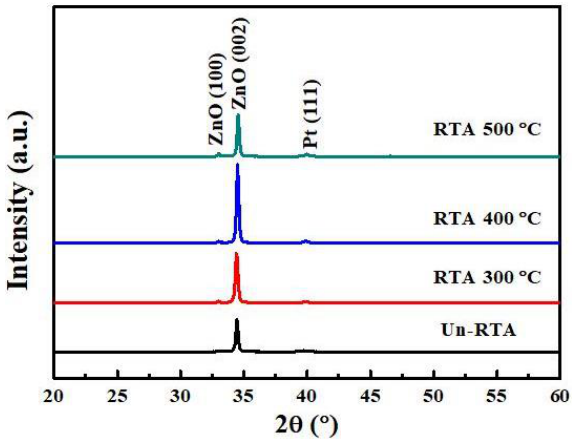
Figure 2. XRD patterns of the ZnO thin films annealed with various temperatures for 10 min.